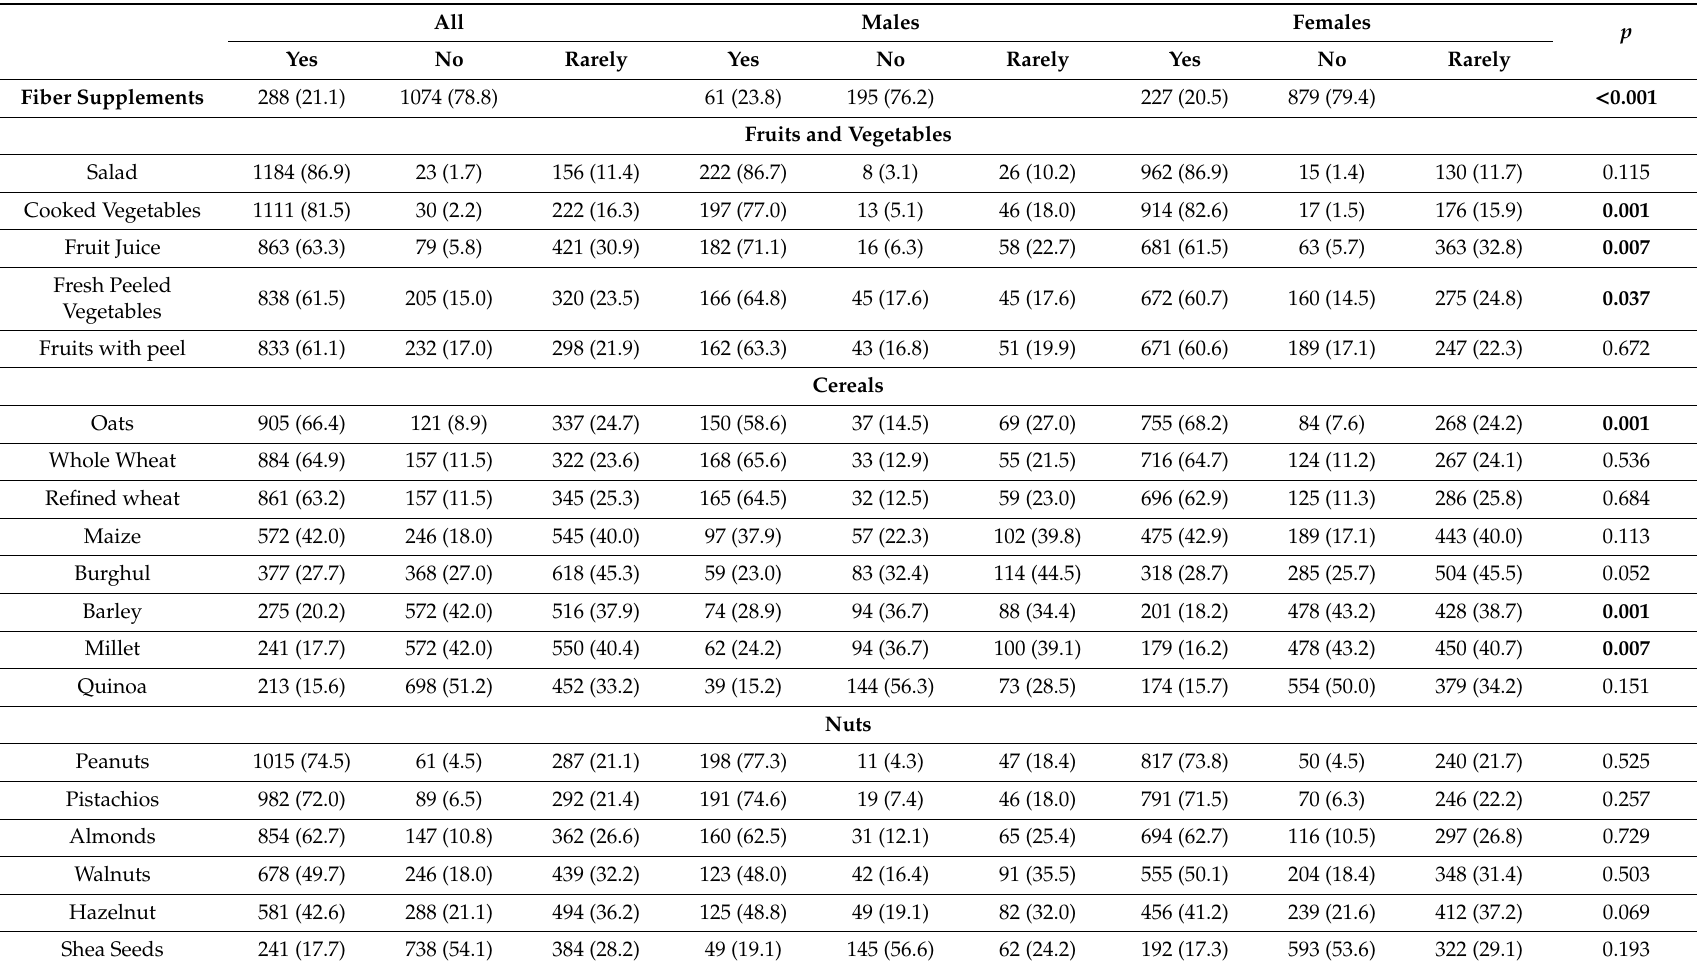
Table 2. Consumption of fiber-rich foods and supplements among